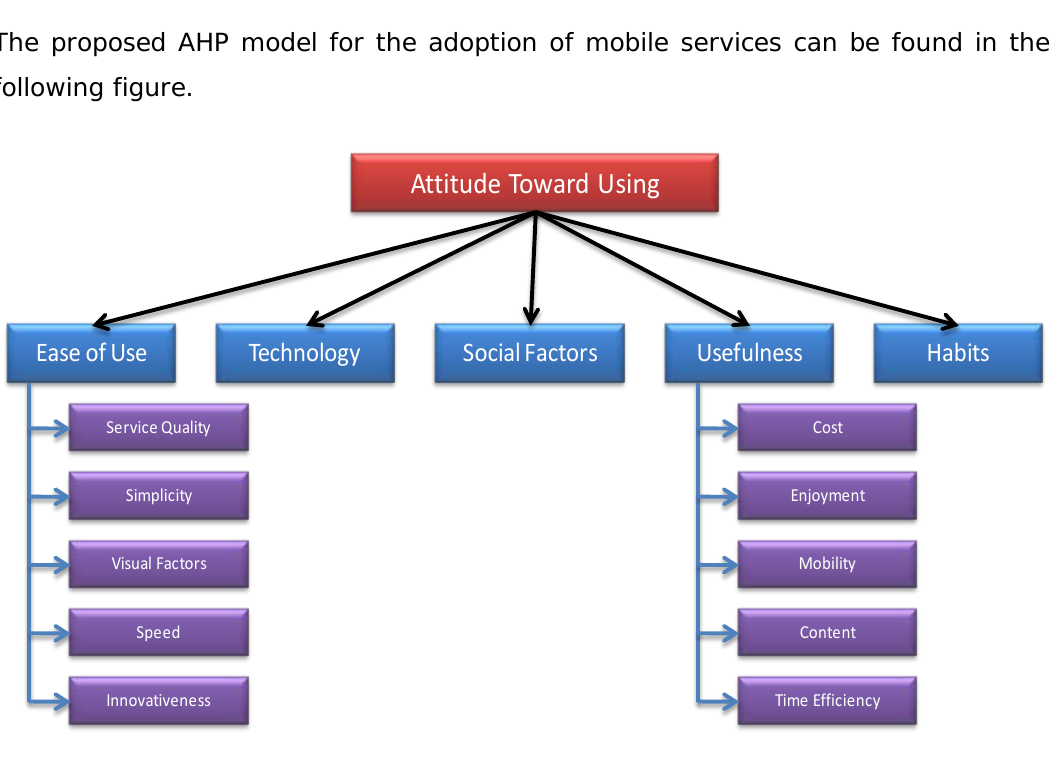
Figure 2. “AHP Model for the Adoption of Mobile